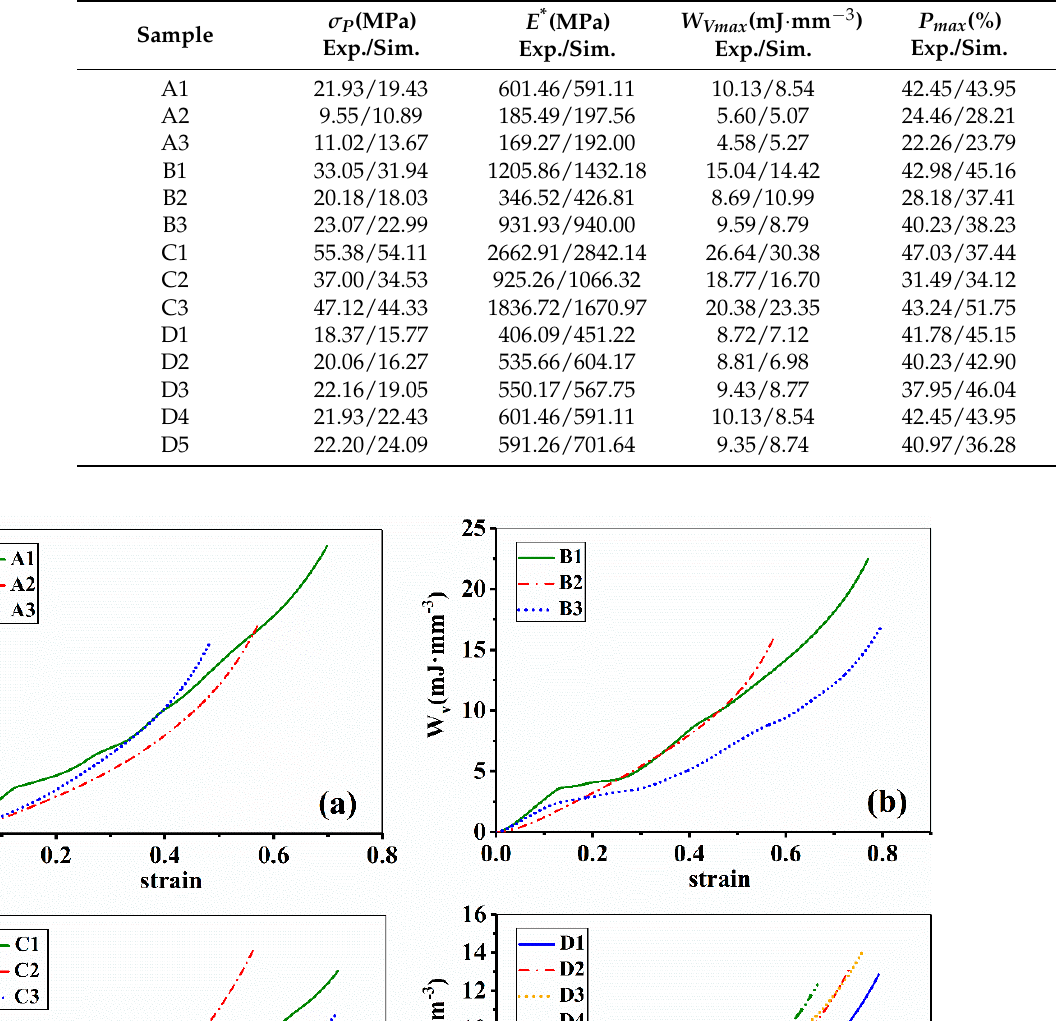
Table 3. Representing mechanical properties of samples.